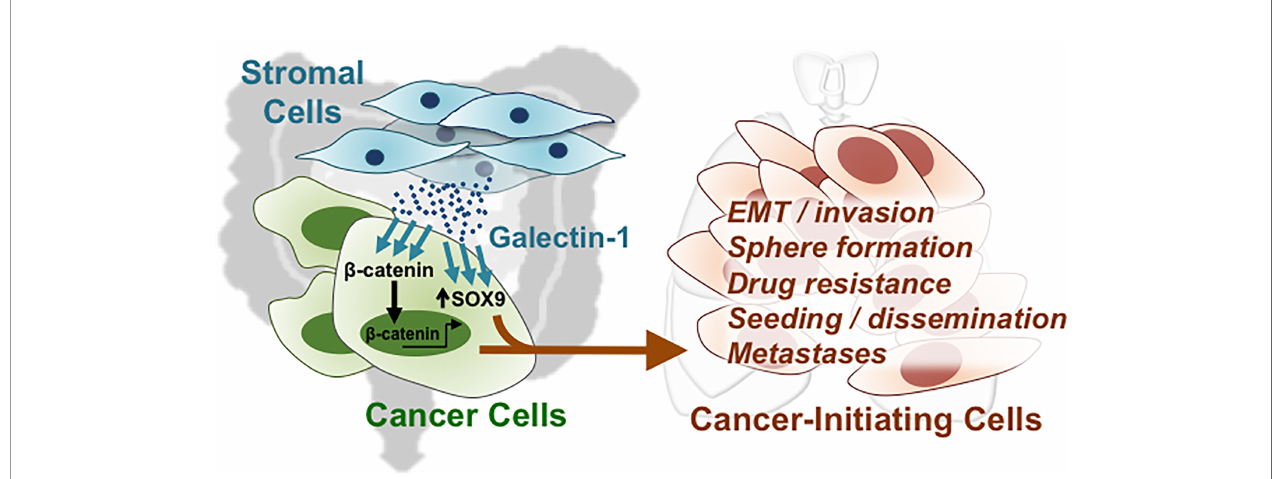
FIGURE 7 | Direct targeting of stromal-secreted Gal-1 on CRC cells promote CIC features and disease progression through SOX9 and b